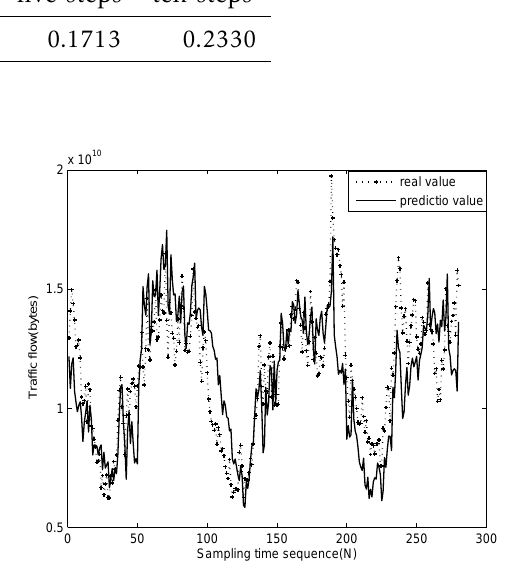
Figure 1. RRMSE of different number of predicted samples. Figure 2. Comparison between the real and prediction traffic (number of samples is